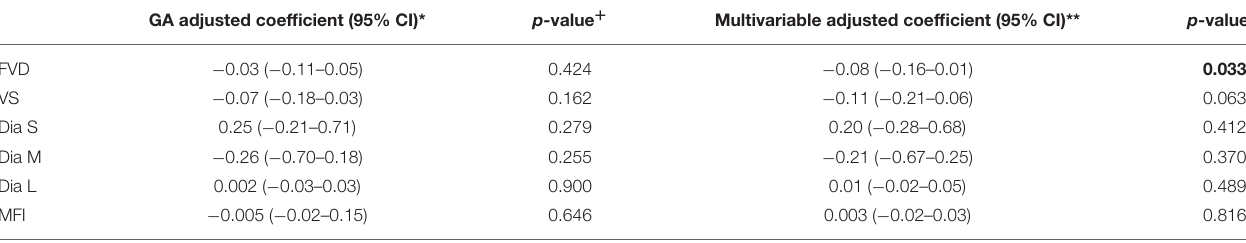
TABLE 4 | Mixed-effects linear regression model of the longitudinal association of the microcirculation and postnatal days of life. GA adjusted coefficient (95% CI)* p- value + Multivariable adjusted coefficient (95% CI)**